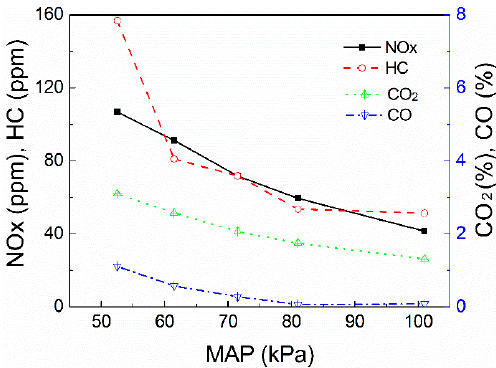
Figure 10. CO 2 , CO, NO x , and HC under the different MAPs.